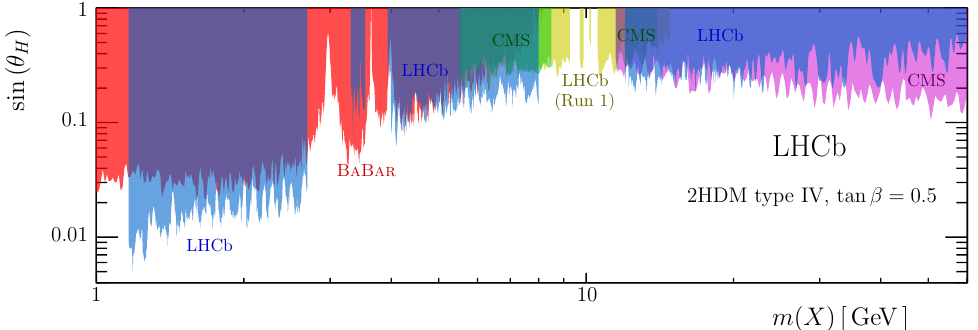
Figure 10 . Upper limits at 90% con(cid:12)dence level on the X { H mixing angle, (cid:18) H , for the 2HDM scenario discussed in the text (blue) from this analysis compared with existing limits from (red) BaBar [57], (green) CMS Run 1 [58], (magenta) CMS Run 2 [59] and (yellow) LHCb Run 1 [60].